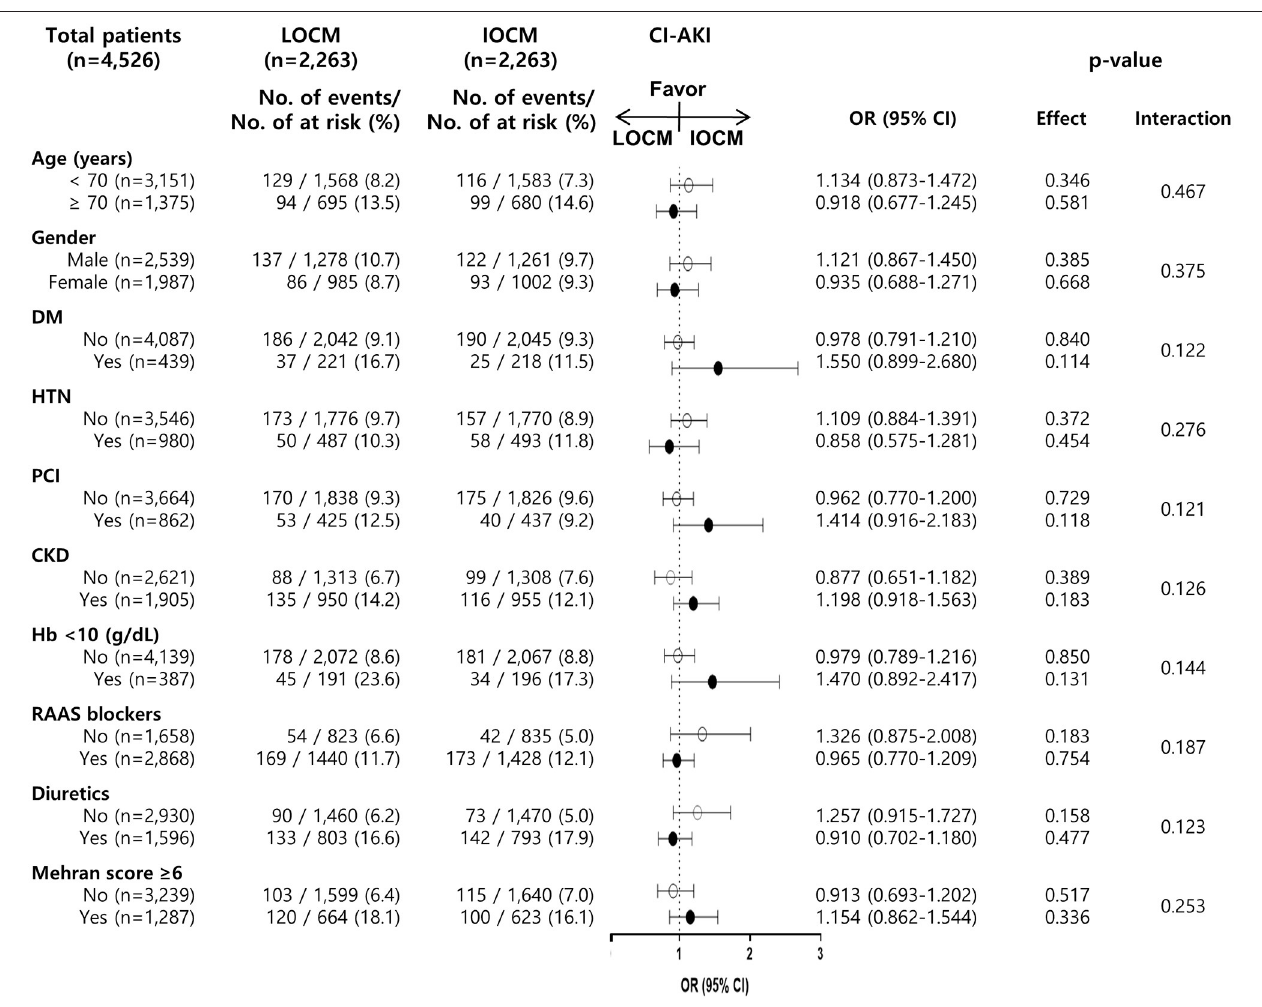
Model 1: adjusted for demographics (age and gender). Model 2: adjusted for demographics and comorbidities (model 1 + smoking status, DM, hypertension, CKD and CHF). Model 3: adjusted for demographics, comorbidities, and medications (model 2 + RAAS blockers, CCBs, β -blockers, diuretics and statins). Model 4: adjusted for demographics, comorbidities, medications, and laboratory findings (model 3 + hemoglobin, albumin and contrast volume).